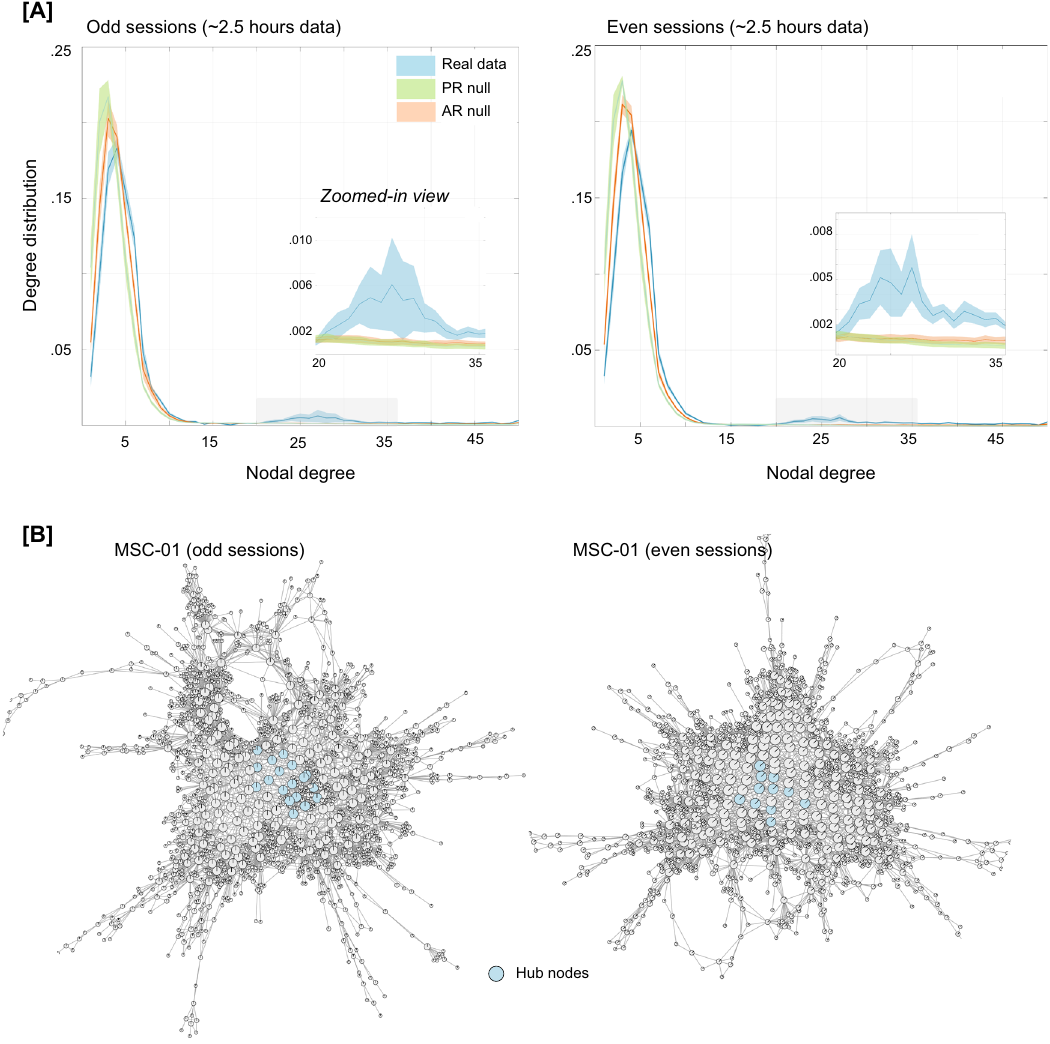
Fig. 2 | Characterizing the Mapper-generated graph using degree distribution. A Degreedistributionsaveragedacrossthetenparticipants,separatelyforoddand even sessions. For examining linear vs. nonlinear aspects, two null models were used, namely, the phase randomized null and the multivariate autoregressive null model. As evident from the degree distribution plots,realdatashowasigni fi cantly fat tail (>20) as compared to both nulls. This fi nding was independently replicated